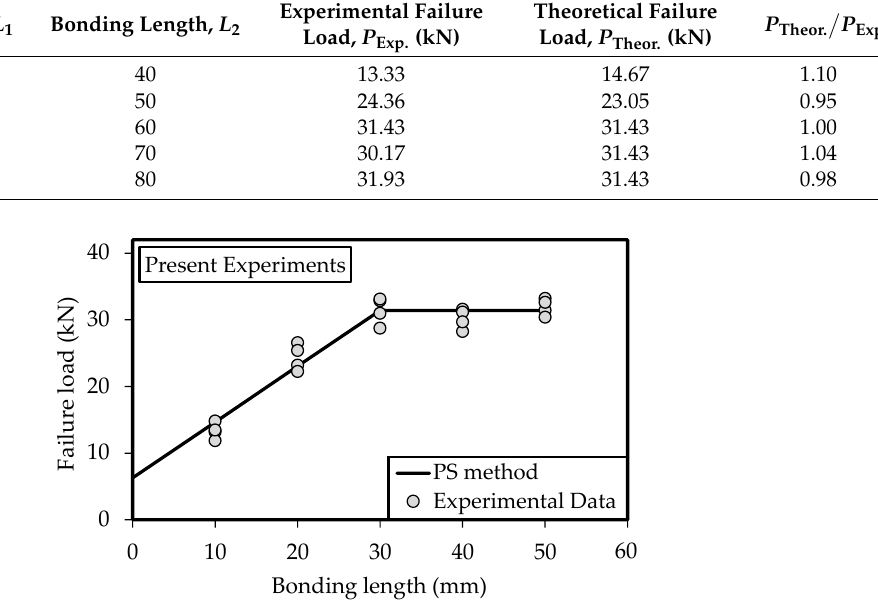
Figure 9. Comparison between the experimental failure loads of DSJs and the theoretical predictions obtained by means of point stress (PS) method. Table 3. Dimensions of the adhesive joints and details of experimental and theoretical failure loads for the tested DSJs.